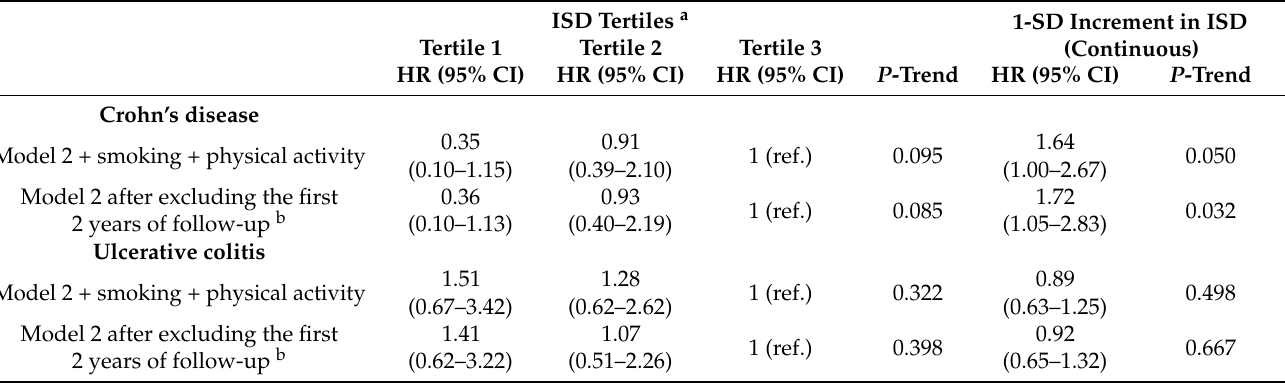
Table 3. Sensitivity analyses of the association of the Inflammatory Score of the Diet (ISD) with incidence of Crohn’s disease and ulcerative colitis.